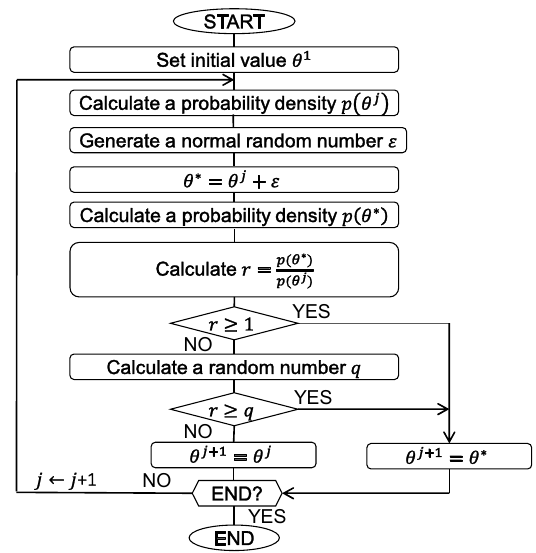
Figure 4. Flowchart of Metropolis–Hastings algorithm.